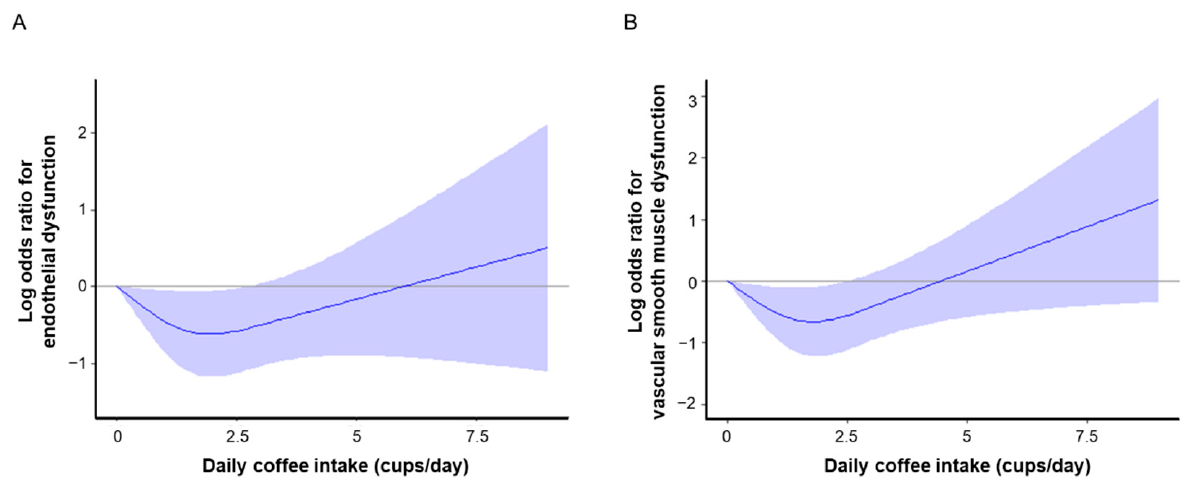
Figure 2. Cubic splines of the relationships of amount of daily coffee intake with log odds ratios for endothelial dysfunction ( A ) and vascular smooth muscle function ( B ). Endothelial dysfunction was defined as flow-mediated vasodilation of less than 1.6% and vascular smooth muscle dysfunction was defined as nitroglycerine-induced vasodilation of less than 8.4%. Vertical lines show 95% confidence intervals.